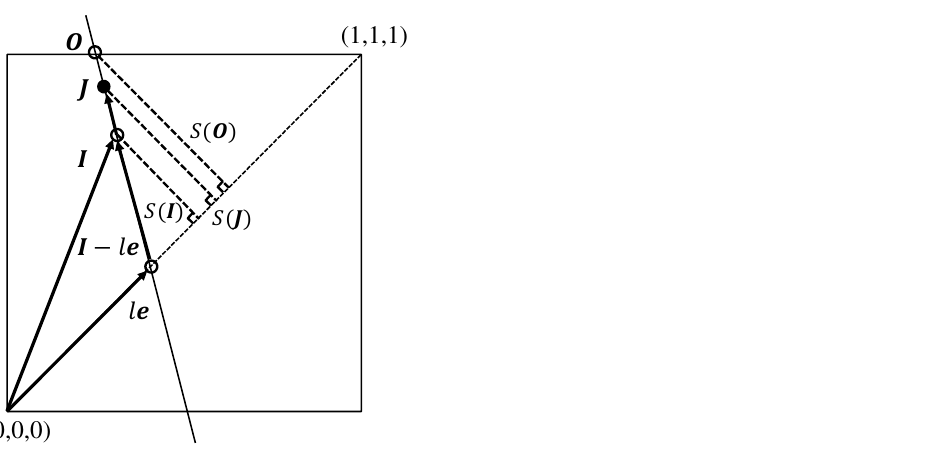
Figure 1. Straight line J satisfying equal hue and equal lightness in RGB color space, and chroma S of each color on J .